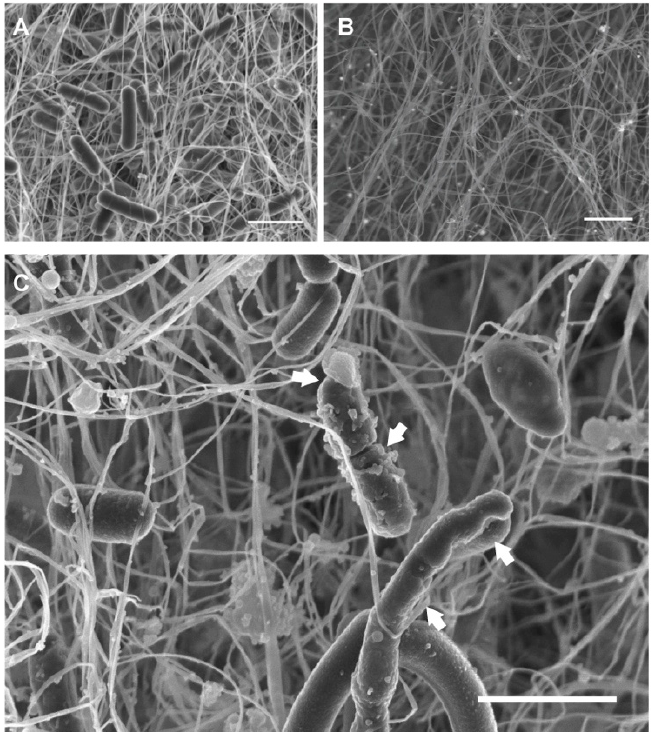
Figure 3. FESEM images of the two-sided biomaterials. ( A ) The side containing Lf exhibited the typical rod-like morphology of this bacterium. ( B ) BC side containing AgNPs. ( C ) Lf -functionalized BC surface, containing a higher amount of AgNPs (30 min of incubation in the AgNPs solution). Arrows show the cell wall damage. Scale bars: 2 μ m. Molecules 2021 , 26 , x FOR PEER REVIEW